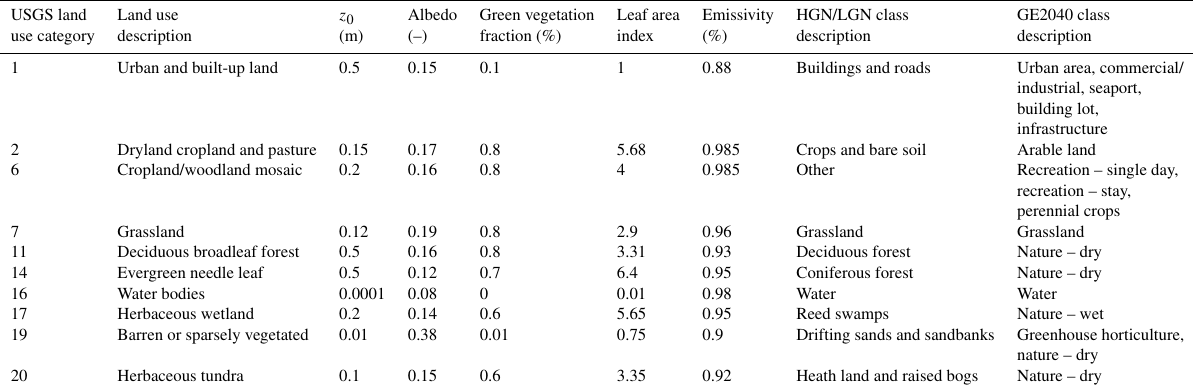
Figure 3. Dutch land use maps for 1900, 2000, and 2040 based on HGN1900, LGN4, and GE2040, respectively. Table 1. USGS land use category descriptions and parameter settings used in WRF, with the national land use map (HGN, LGN, and GE2040) classes that are reclassified as